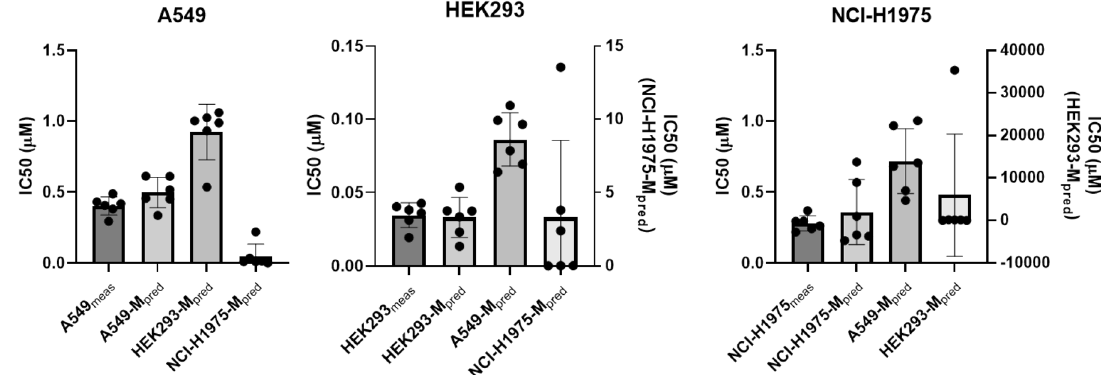
Figure 6. Distribution of IC50 values from 6-repeated tests of doxorubicin effects. Measured and predicted IC50 for three cell types compared to each other. The results of the statistical analysis are provided in Table 2.